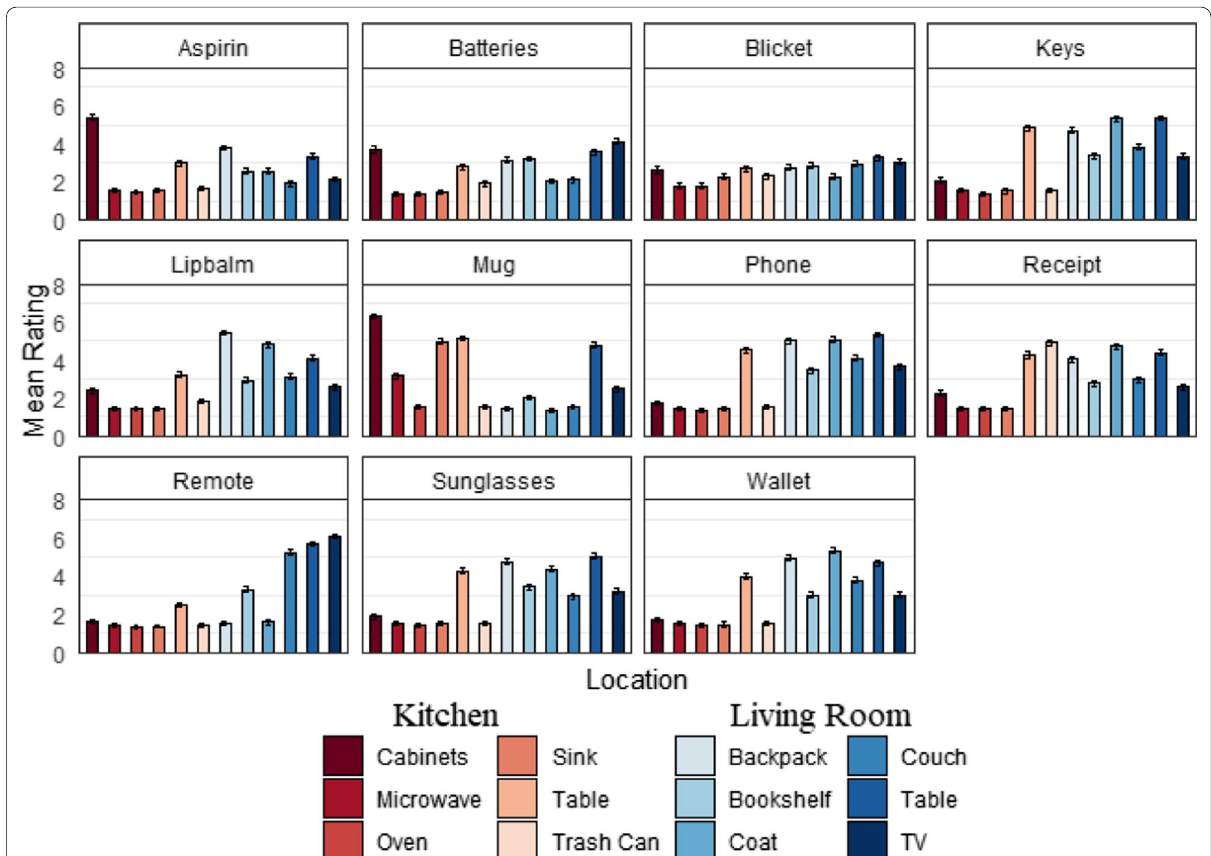
Fig. 2 Mean likert ratings for experiment 1. Error bars represent one standard error of the mean ( N =